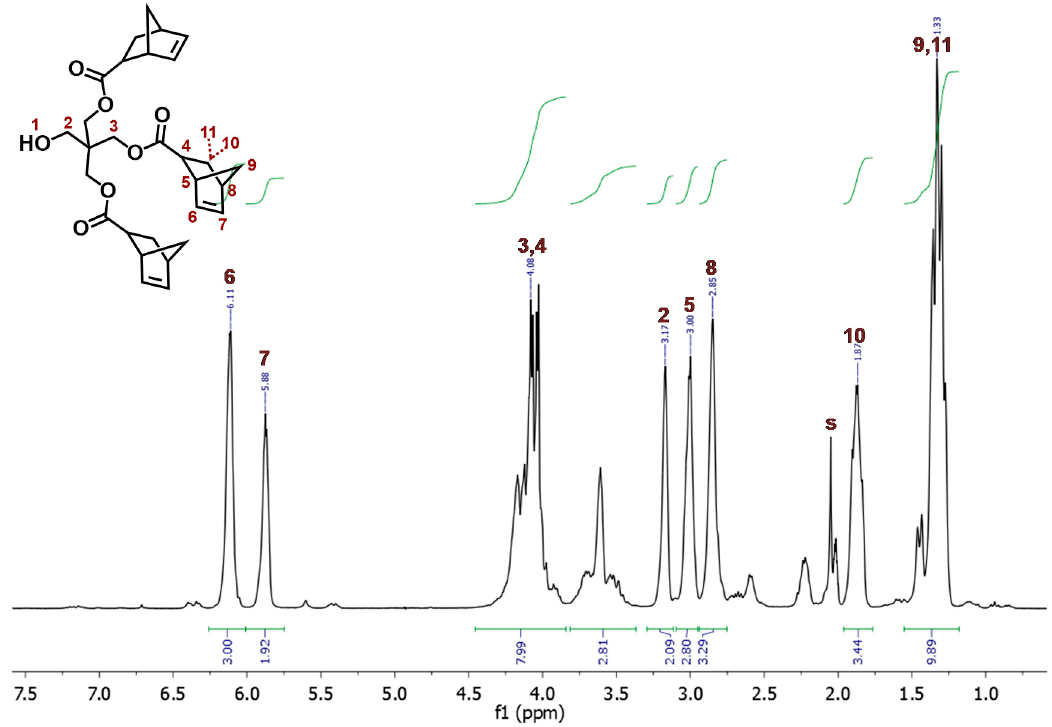
Figure 4. 1 H-NMR spectrum of pentaerythritol-norbornene-carboxylate (PETNC) in acetone-d 6 .